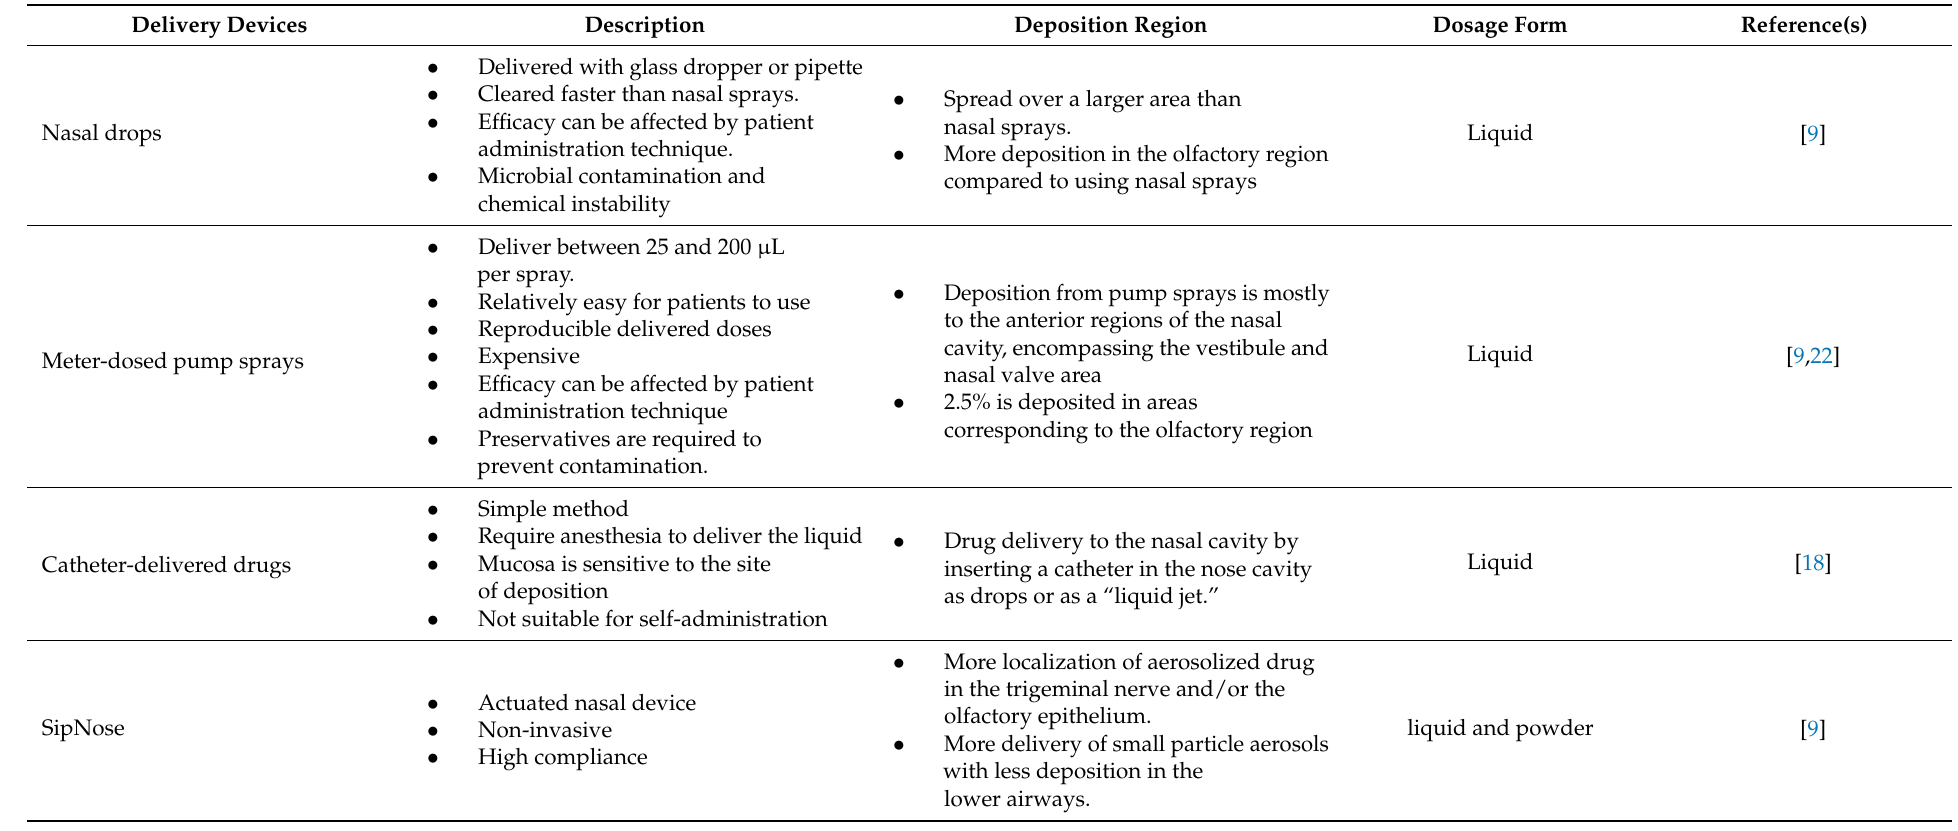
Table 1. Examples of Nasal Delivery Devices with a brief description of the principles, dosage form, and